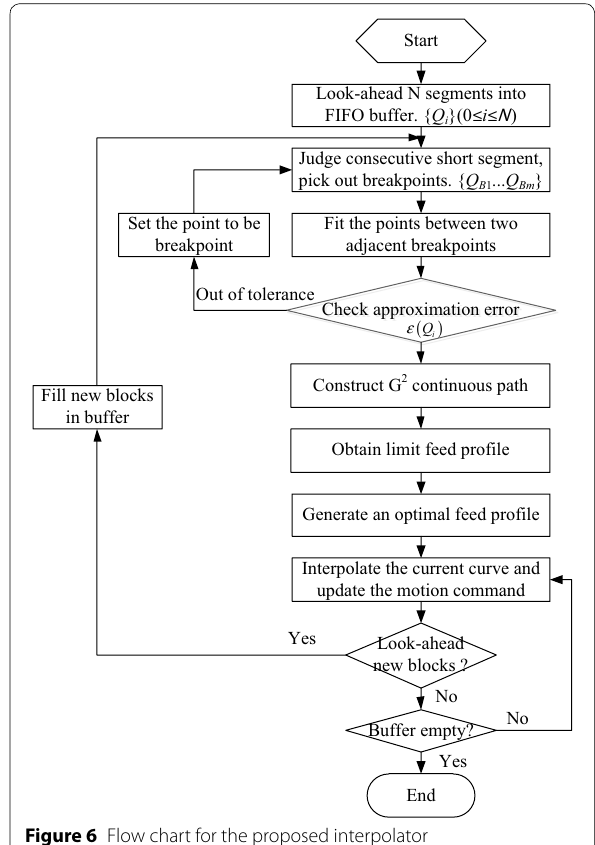
Figure 6 Flow chart for the proposed